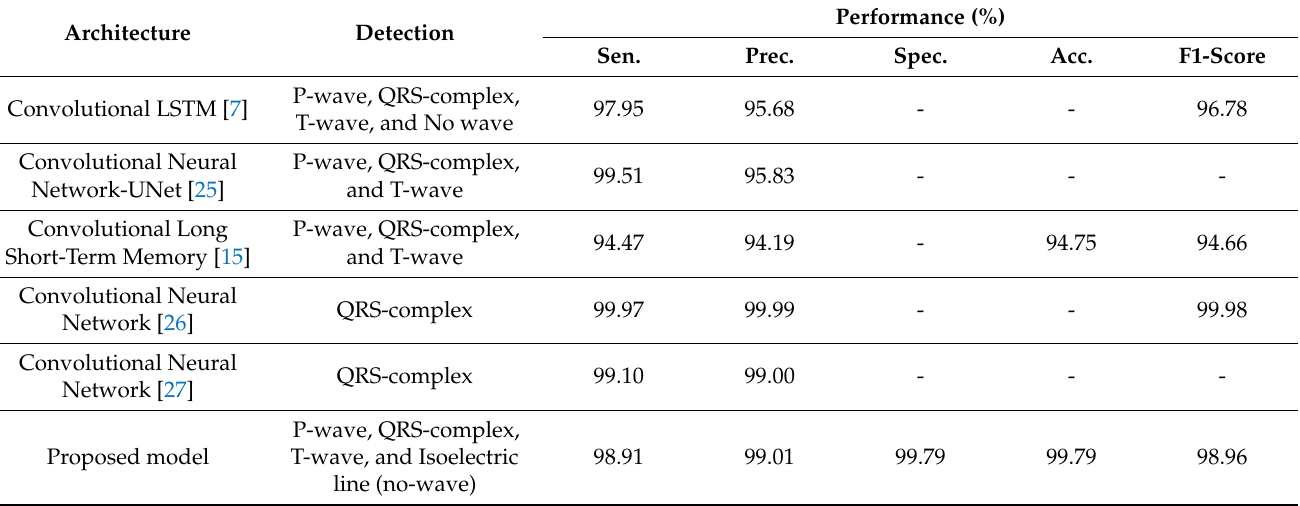
Table 6. Comparison with other delineation using deep learning model with the same QTDB